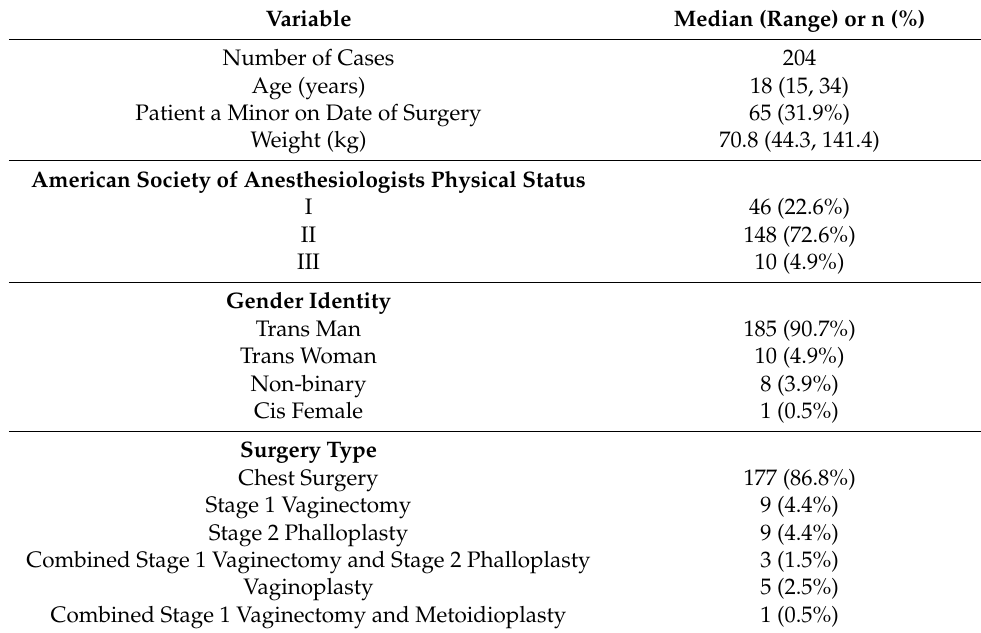
Table 1. Demographics and Patient